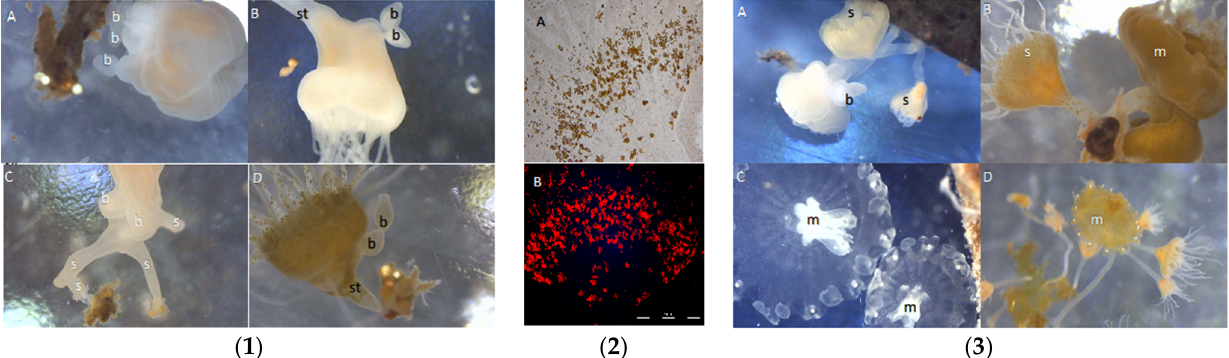
Figure 6. Settlement and metamorphosis of C. xamachana ( A ) and C. frondosa ( B ) on substrates from a shallow habitat (1–2 m) for 4 days (orange = Day 0, yellow = Day 1, green = Day 2, maroon = Day 3, brown = Day 4). Mean ± s.d. (n = 4).